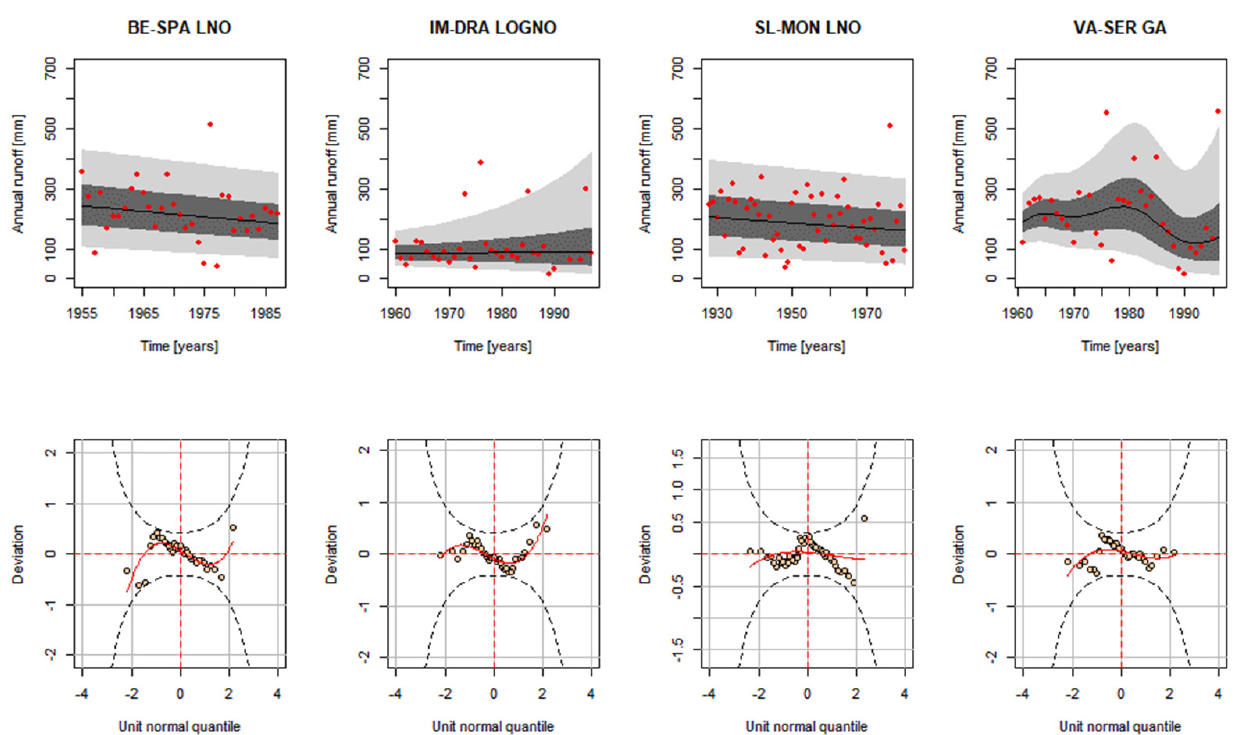
Figure 9. Centiles plots ( first row ) of the best model for the four considered stations. In the ( second row ) the corresponding worm plots are displayed. The legend for the first line is the same as in Figure 5.